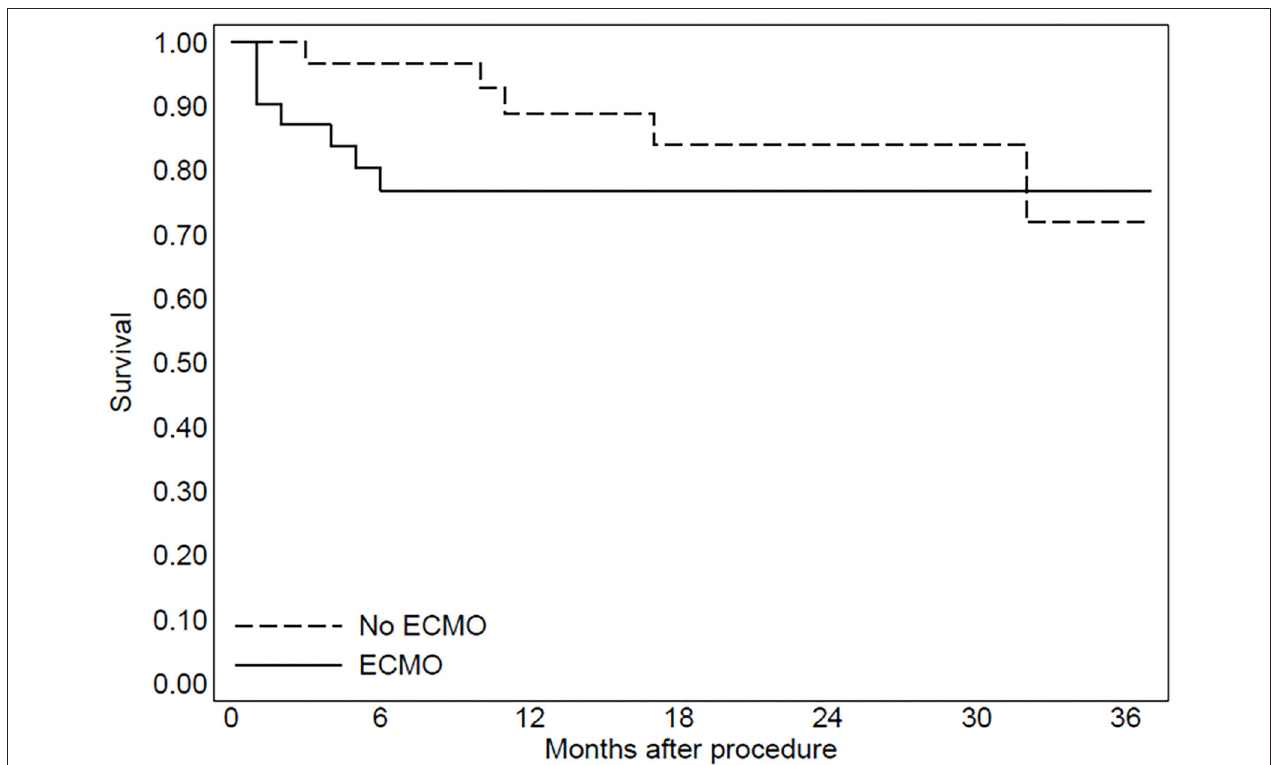
FIGURE 2 | The Kaplan-Meier curve to evaluate mortality due to refractory heart failure after the